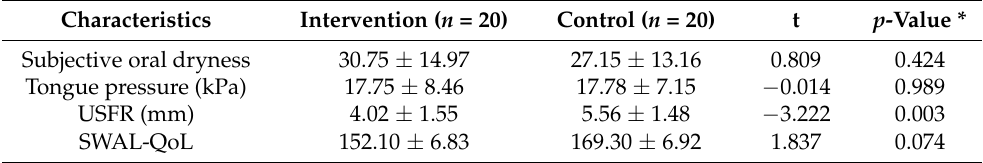
Table 3. Homogeneity of dependent variables between the intervention and control groups.